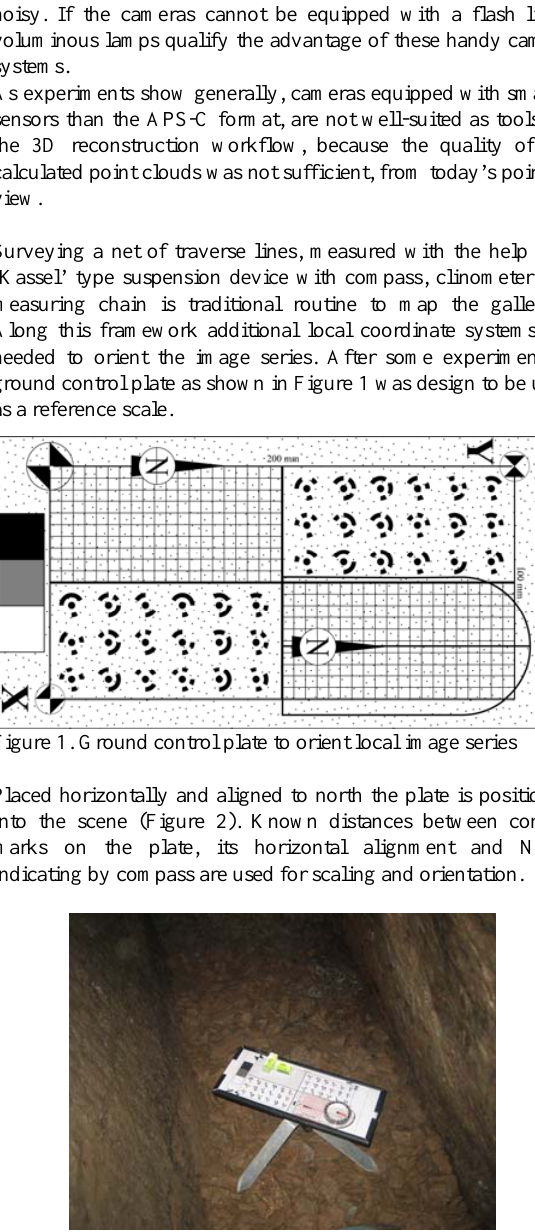
Figure 2. Ground control tablet, levelled and aligned to north, situated into the recorded